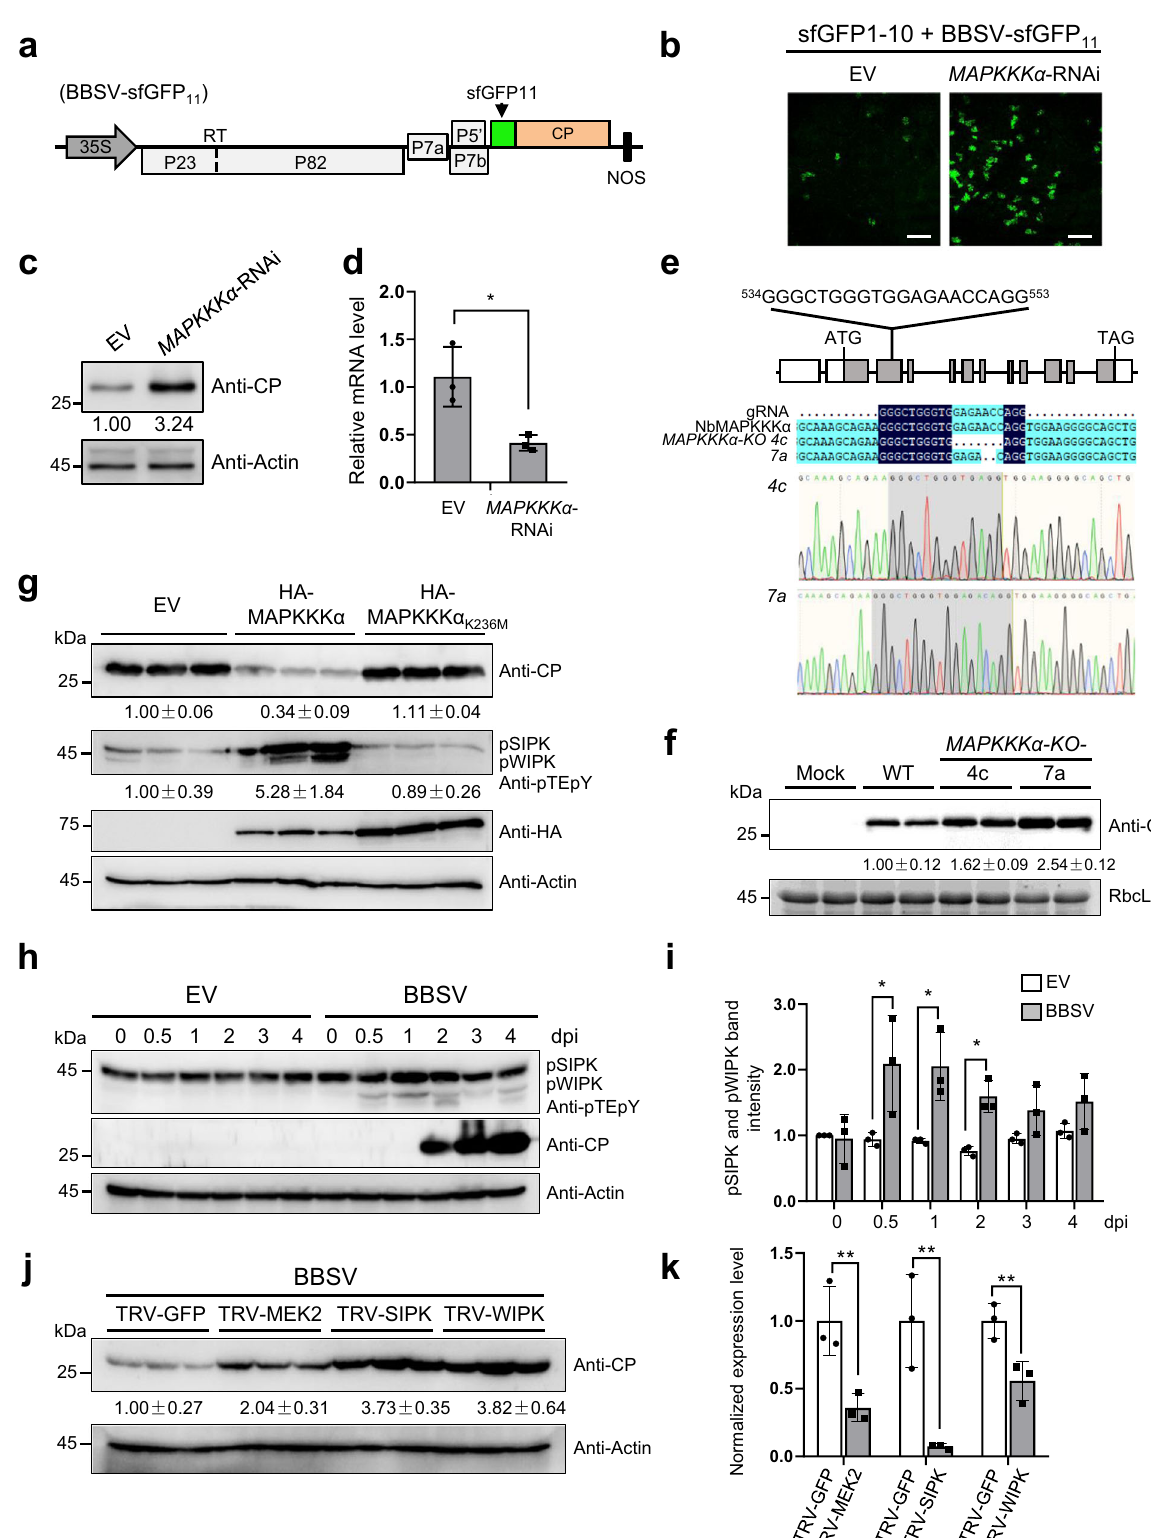
accumulation (Fig. 1g, top panel). Moreover, the phosphorylation levels of two MAPKs, NbSIPK, and NbWIPK, which were reported to act downstream of MAPKKK α 32 were higher in the leaves overexpressing MAPKKK α compared with EV and MAPKKK α K236M (Fig. 1g, middle panel). Furthermore, the expression of MAPKKK α induced cell death but not